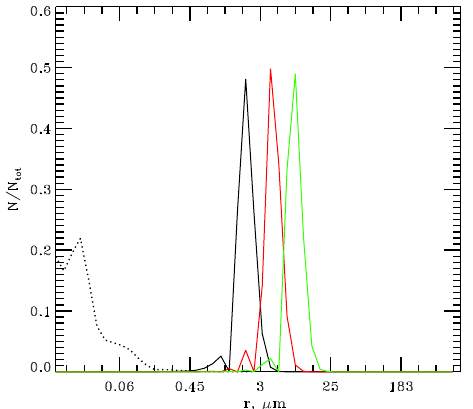
Figure 1. Relative distribution of particles averaged over the do- main at t = 0s (black dotted curve) and at t = 3s (solid curve) for the cases of N tot = 55 . 5cm − 3 (green solid curve), N tot = 555cm − 3 (red solid curve) and N tot = 5550cm − 3 (black solid curve). Dotted curve corresponds to the observed distribution of aerosol; solid and dashed curves are distributions of